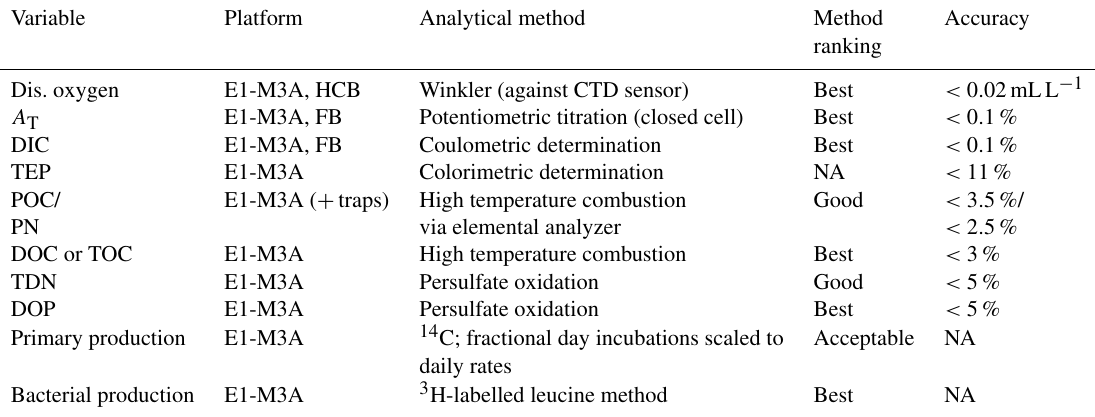
Table 3. Variables measured from discrete bottle samples at low frequency (6 to 24 months) and from sediment traps (integrating 15 days). Method ranking is from Lorenzoni and Benway (2013). + traps: measurement from both water column samples and from particulate matter in sediment traps. FB: